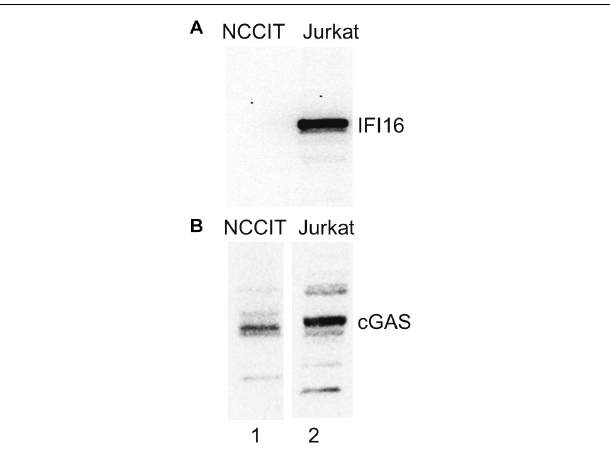
FIGURE 4 | No IFI16 detected in NCCIT cells. NCCIT and Jurkat cells were lysed according to the method used in the pulldown experiments. The samples were then analyzed by SDS-PAGE and western blotting for IFI16 and cGAS. (A) IFI16 is not detected in NCCIT (lane 1) but is highly expressed in Jurkat cells (lane 2). (B) In contrast, cGAS is detected in both NCCIT (lane 1) and Jurkat (lane 2) cell lines. Aliquots of the same samples were used in panels (A,B) but loaded on separate SDS-PAGE